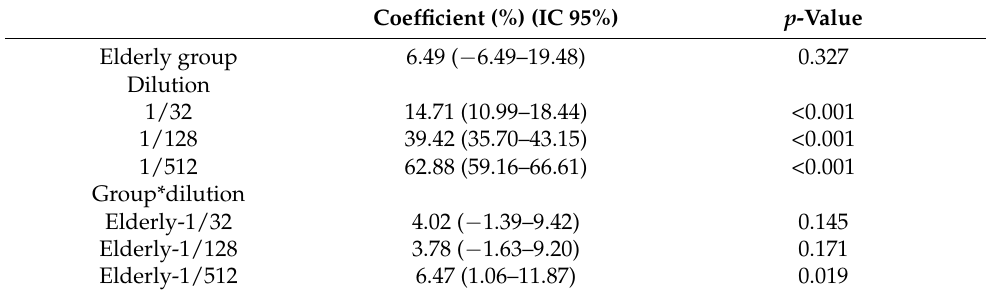
Table 2. Interaction between groups and serum dilution. The interaction term is